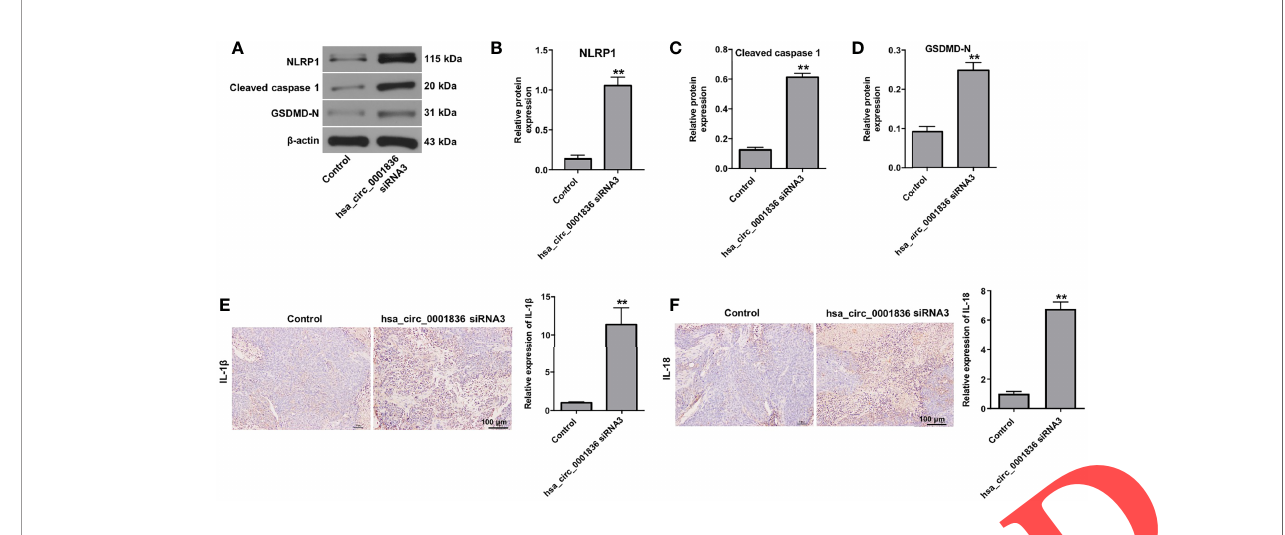
FIGURE 6 | Knockdown of hsa_circ_0001836 inhibited tumorigenesis in U251MG xenografts in vivo via activation of NLRP1-GSDMD signaling. U251 cells (1×10 7 cells) were injected into nude mice subcutaneously, and hsa_circ_0001836 siRNA3 (50 nM) was injected into the tumors directly twice a week. (A – D) Western blot analysis of NLRP1, cleaved caspase 1, GSDMD-N levels in tumor tissues. The relative expressions of NLRP1, cleaved caspase 1, GSDMD-N in tumor tissues normalized to b -actin. (E, F) IHC analysis was applied to determine the expressions of IL-1 b and IL-18 in tumor tissues. **P < 0.01 vs. control